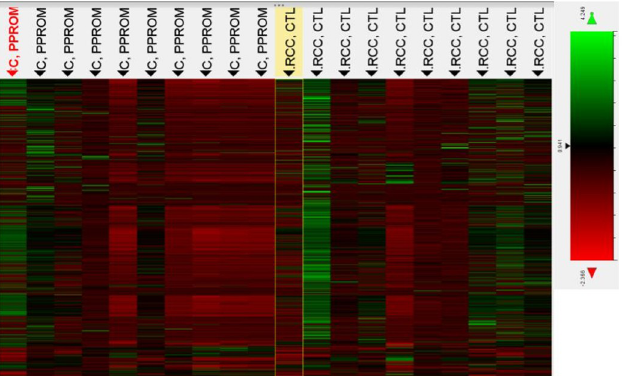
Fig 1. Heatmap of miRNA expression in PPROM and control group for all 800 targets with color key.